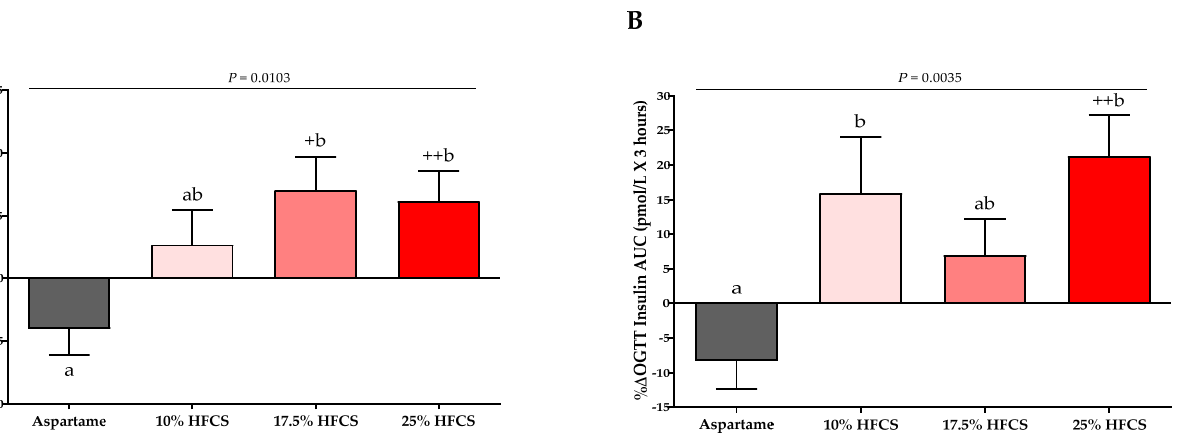
Figure 3. Changes in Predicted M ISI and Matsuda ISI: Mean ± SEM of the % changes in ( A ) Predicted M Insulin Sensitivity Index (ISI) in participants consuming 0 ( n = 22), 10 ( n = 16), 17.5 ( n = 14), or 25% ( n = 27) and ( B ) Matsuda ISI in participants consuming 0 ( n = 23), 10 ( n = 18), 17.5 ( n = 15), or 25% ( n = 28) HFCS-sweetened beverages for two weeks. p = effect of HFCS group, two-factor (HFCS group, sex) ANCOVA with adjustment for MSRF; + p < 0.5, ++ p < 0.01, LS mean different from zero; a different from b, Tukey’s.